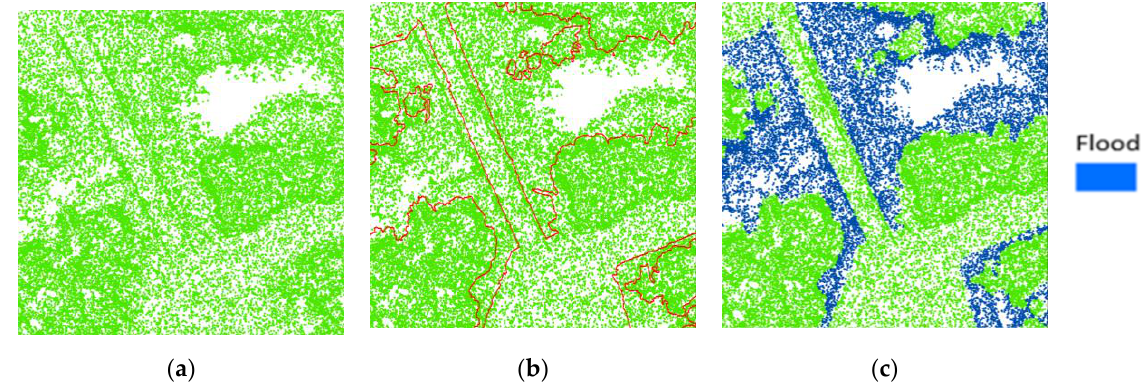
Figure 5. Three-dimensional surface reconstruction using method 1. ( a ) SfM-based unclassified point cloud; ( b ) overlaying flood extent polygons (red polygons) on the point cloud; ( c ) 3D point cloud classification for flood and non-flood point data. Note: the figures show a small portion of the study area (clipped) for the sake of visualization of the dense point cloud.